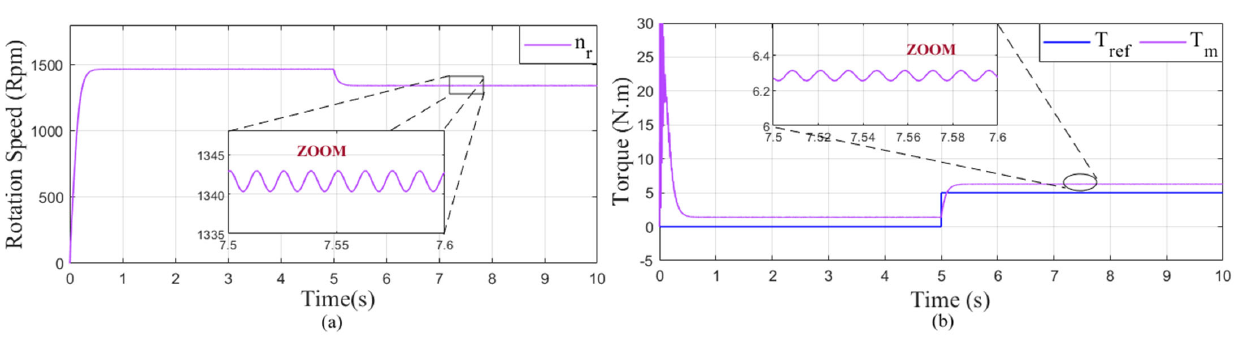
Figure 15. Performance with IR bearing defect of IM without control: ( a ) rotation speed and ( b ) motor torque.